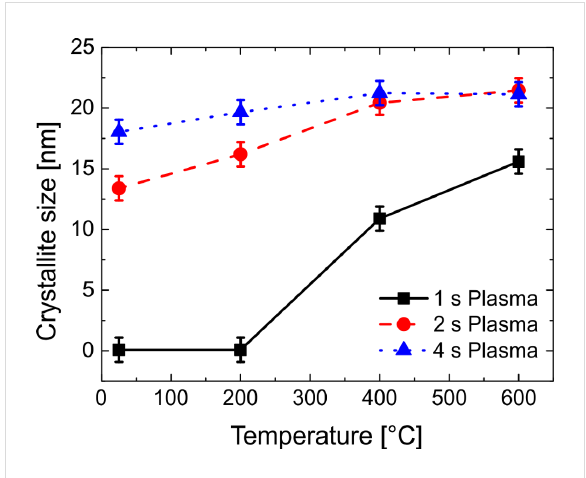
Figure 6: Estimated crystallite size D in the [100] direction as a func- tion of the annealing temperature for the zincone-like layers deposited at different plasma